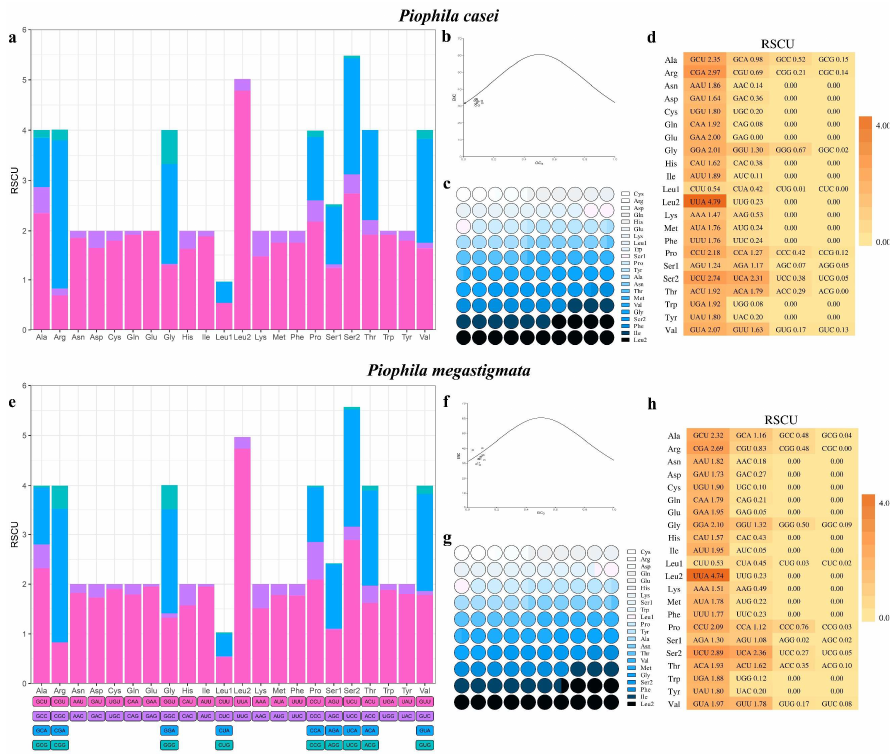
Figure 4. RSCU information of PCGs ( a ) Relative synonymous codon usage (RSCU) in the mtgenomes of P. casei ; ( b ) ENc-plot of P. casei ; ( c ) Amino acid usage graph for P. casei ; ( d ) Heat map of RSCU results for P. casei calculated by CodonW software; ( e ) Relative synonymous codon usage (RSCU) in the mtgenomes of P. megastigmata ; ( f ) ENc-plot of P. megastigmata ; ( g ) Amino acid usage graph for P. megastigmata ; ( h ) Heat map of RSCU results for P. megastigmata calculated by CodonW software. The number of synonymous codons (L_sym) and the total number of amino acids (L_aa) were analyzed [47]. Based on the computational information, the molecular weight (Da), isoelectric points, instability index, aliphatic index, GRAVY, and other indices of the proteins were predicted. The results show that cox1, cox2, cox3, and cytb are structurally stable and can be used for species classification and mutation-related studies (Table 3), which is consistent with the Pi values as well as with the Ka/Ks values analysis [48]. Table 3. Basic information on the protein molecules of the PCGs gene in the complete mt genome of P. casei .